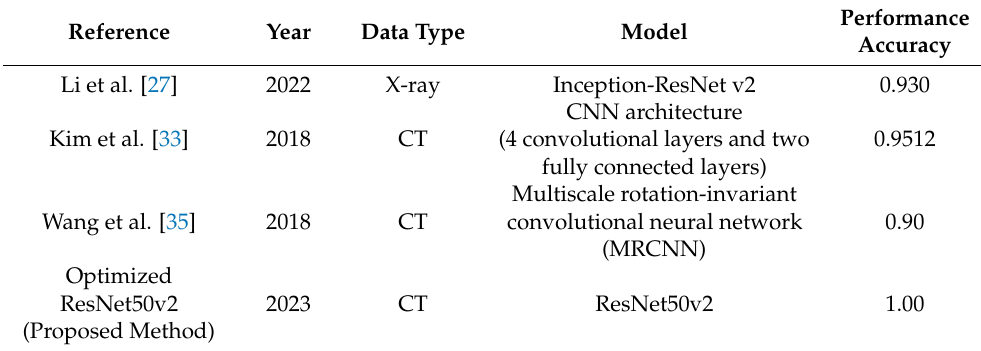
Table 7. A list of related studies on PF classification with their corresponding attainment in different performance